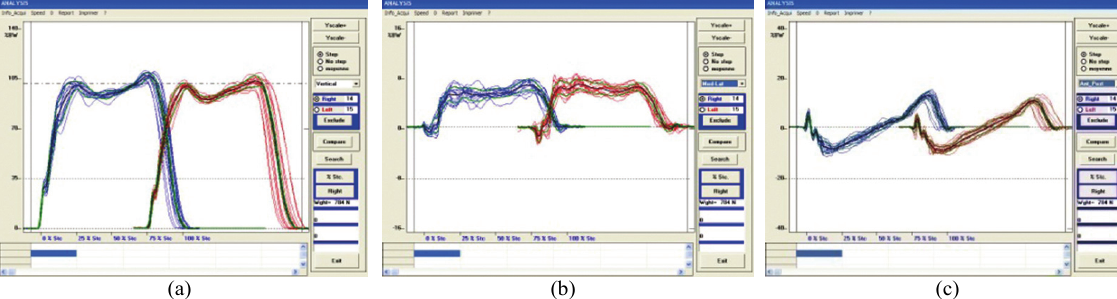
Fig. 10. Force records in (a) vertical, (b) lateral and (c) longitudinal direction for a single test subject measured by the ADAL3D-F during one walking exercise. Left (red) and right (blue) individual steps are overlapped using Adisoft2000 [22].